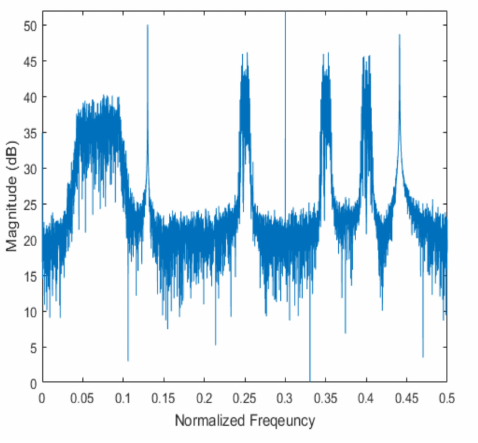
Figure 4. Spectrum of the received signal for the first